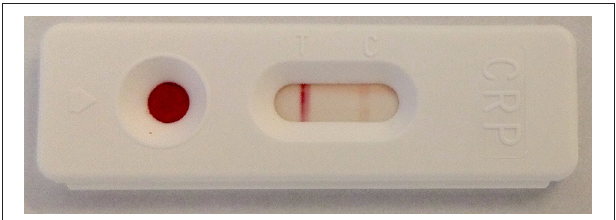
FIGURE 3 | Example of a negative CRP test (T-line is more intense in color than